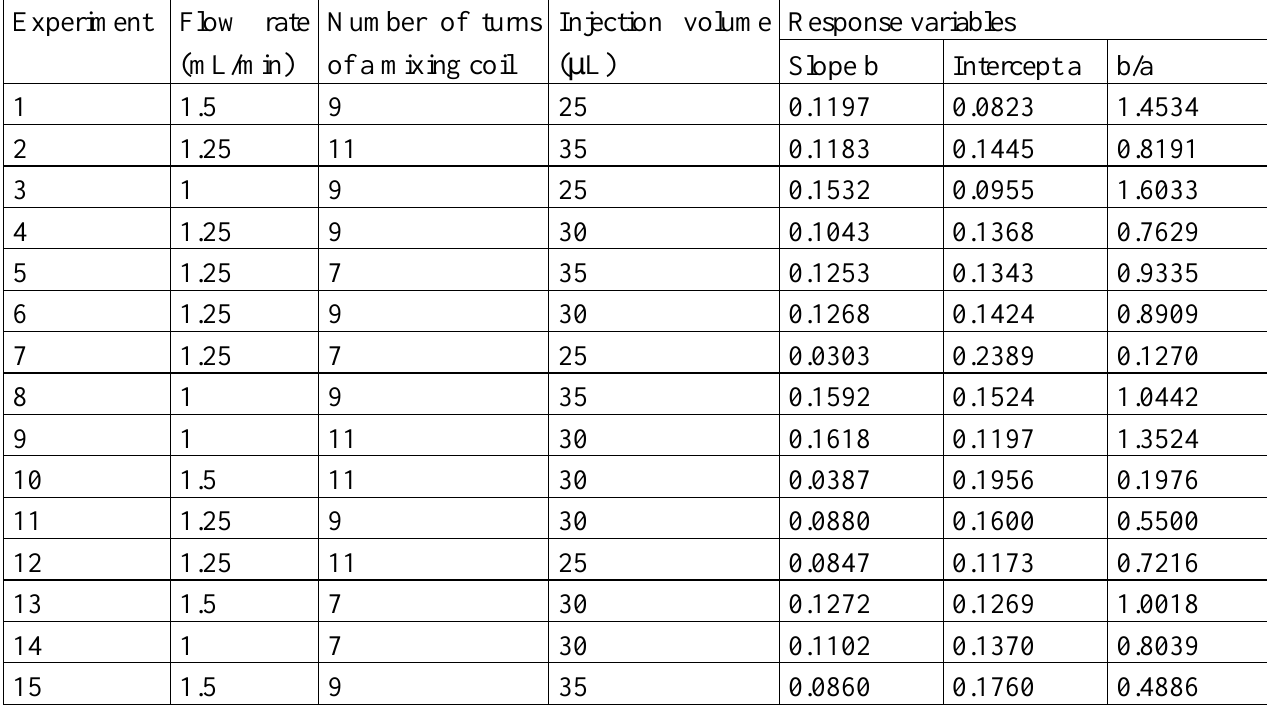
Table 2. Box-Behnken – response surface design for hydrogen phosphate determination optimization.